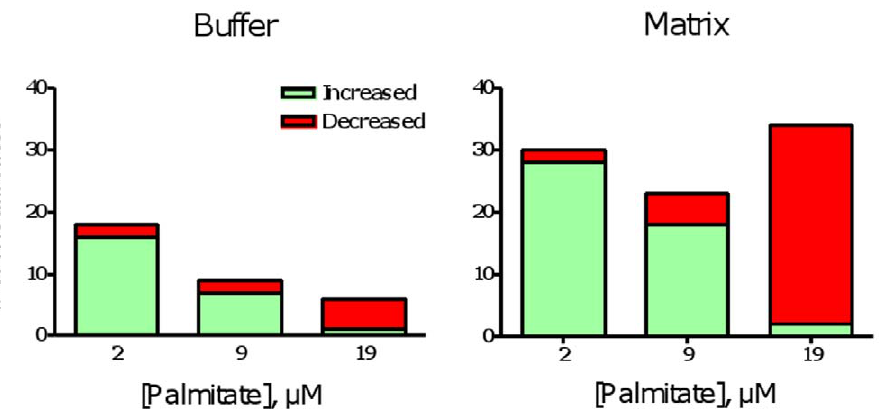
Figure 3. Numbers of metabolites that changed significantly in concentration (P , 0.05, paired t-test) in buffer and matrix fractions obtained from skeletal muscle mitochondria oxidizing LCFA at different rates.